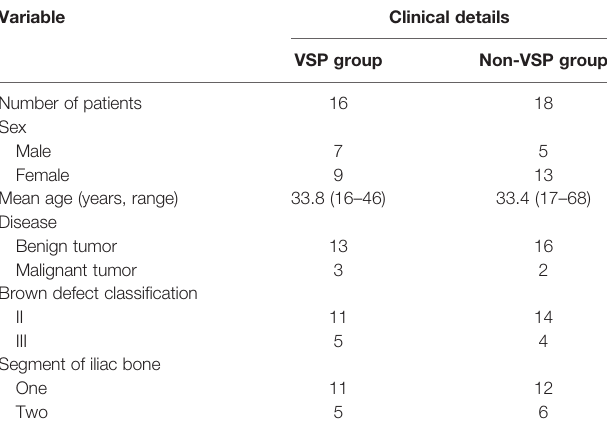
TABLE 1 | Patients ’